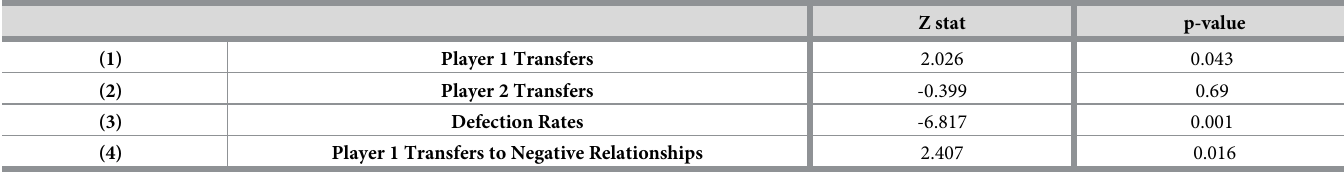
Table 3. Comparisons of trust game transfers and defection rates across